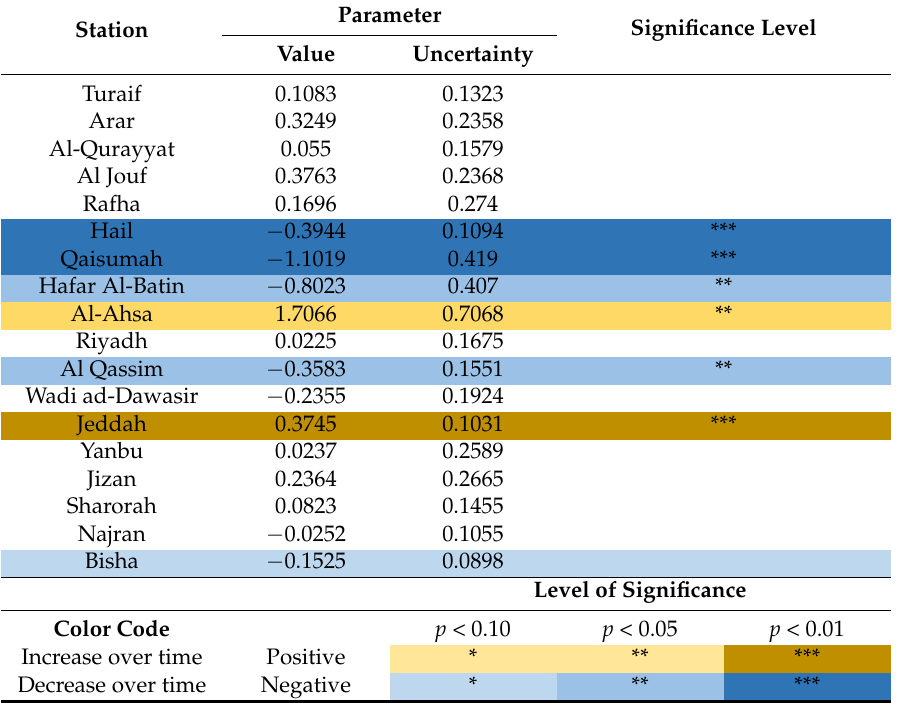
Table 1. Slope coefficient values of the temporal linear regression analysis (annual change in number of dust storms) with associated standard error value (and level of confidence). Rows are colored by the sign of the trend (yellow for positive, blue for negative) and significance of trend (darker is more